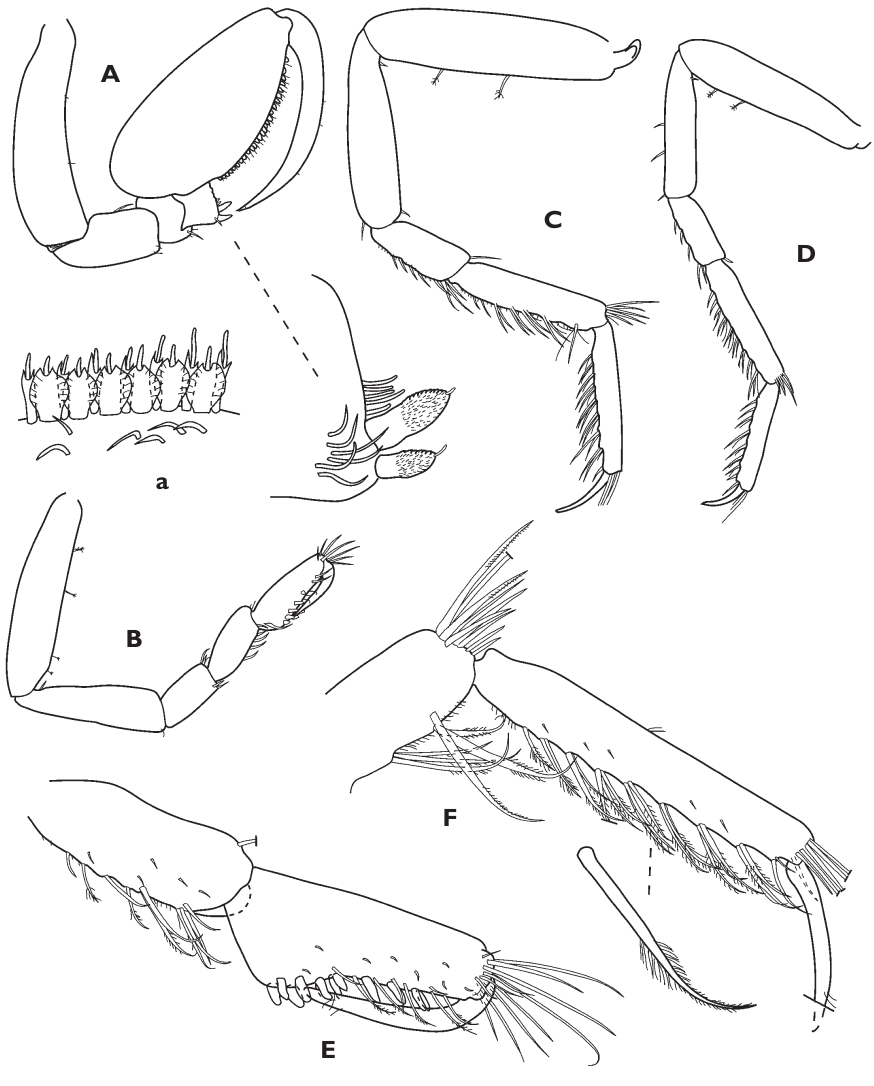
Figure 22. Myopiarolis systir sp. n. Paratype ♂ 11.4 mm, Is.6013, except H, holotype. A–D pereopods 1 2, 6 and 7 respectively a detail of pereopod 1 propodal palm setae E pereopod 2 carpus and propodus F pereopod 6 carpus and